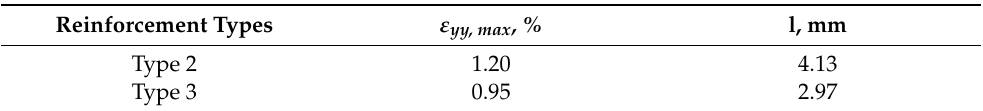
Figure 6. Fields of longitudinal strains ε yy of the surface of specimens of reinforcement types 2, 4, and 5 for a loading of 10% ( a ), 40% ( b ), and 70% ( c ) of the maximum value F OHTu . Table 3. The correspondence of longitudinal strains to the distance from the hole (l), depending on the material